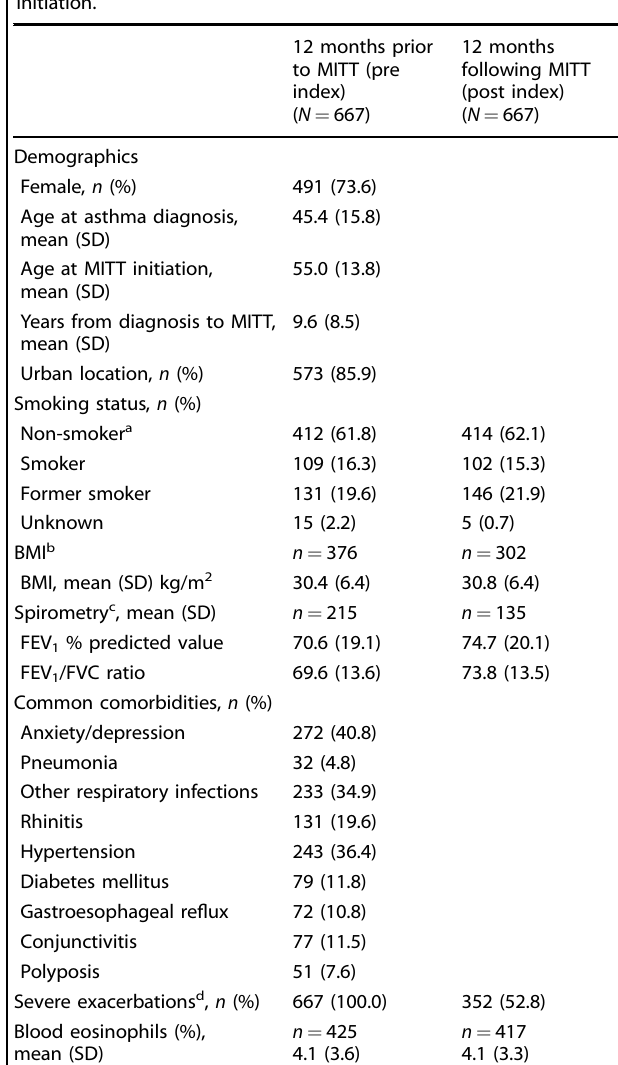
Table 2. Demographics and clinical characteristics 12 months prior to MITT initiation by MITT persistence.